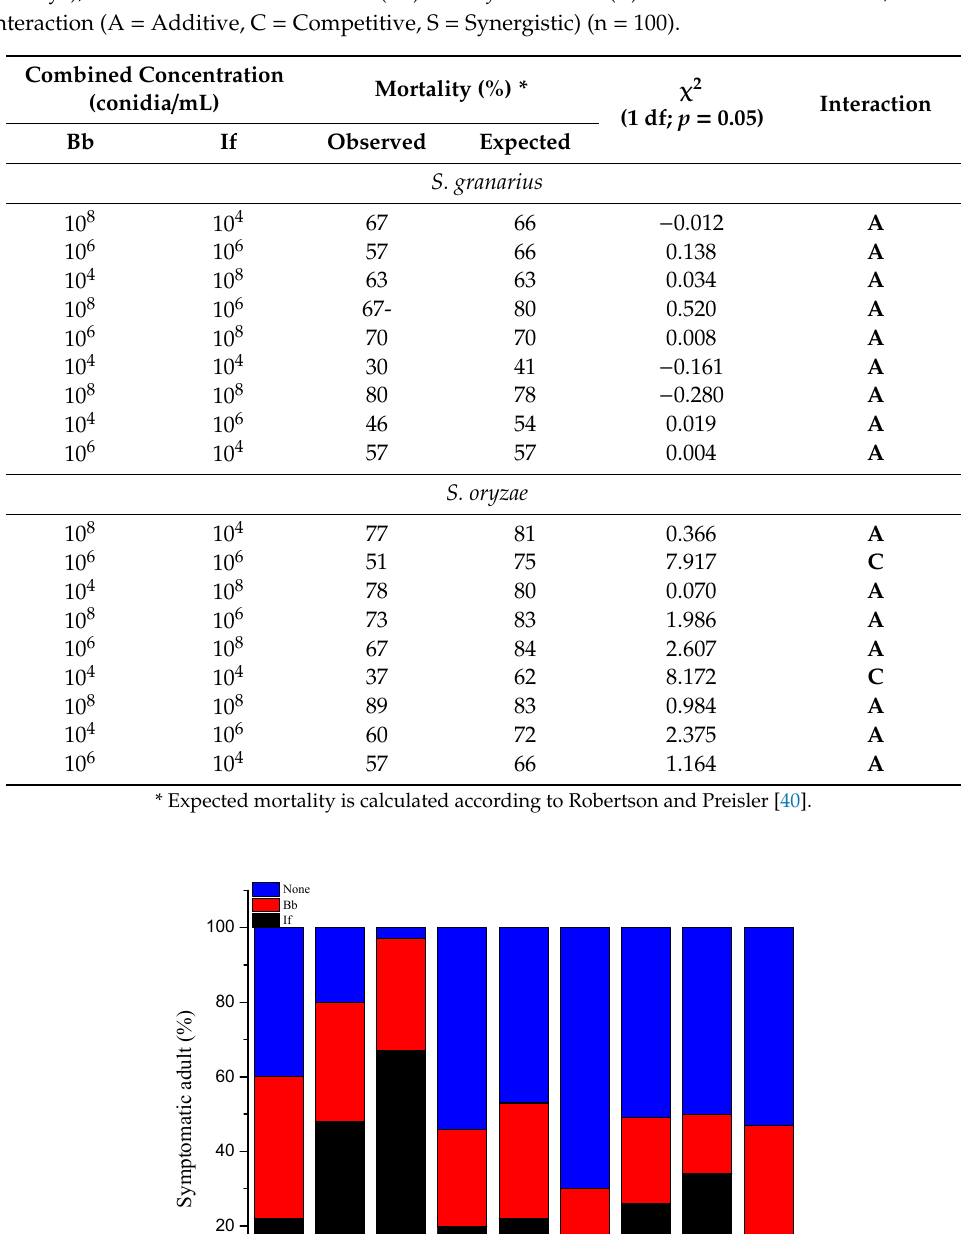
Table 3. Observed and expected mortality of S. granarius and S. oryzae adults at the end of the experiment (15 days), treated with both B. bassiana (Bb) and I. fumosorosea (If) in several combinations, and their interaction (A = Additive, C = Competitive, S = Synergistic) (n = 100).